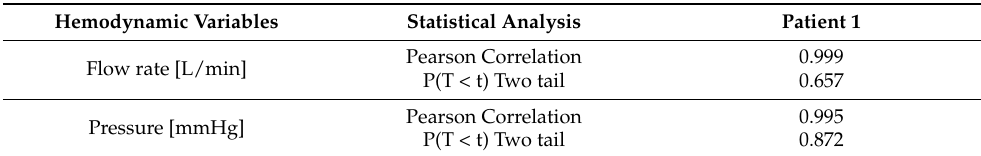
Table 11. Statistical analysis using paired t-test between in-silico and in-vitro measurements on cycle averaged flow rate and pressure findings for patient-1 and patient-2.